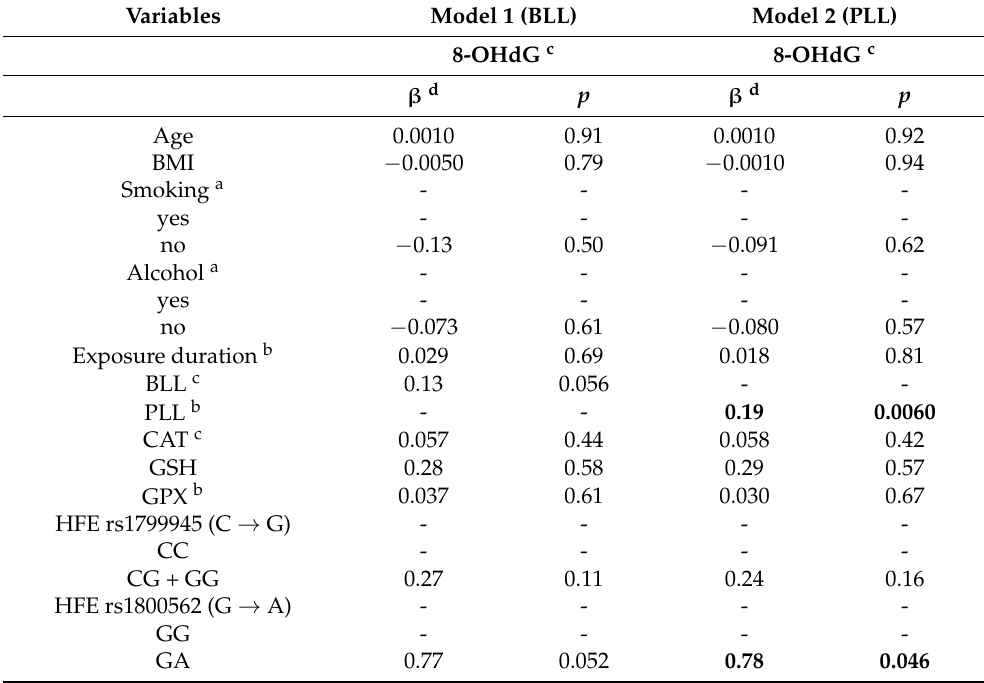
Table 3. Impact of HFE polymorphisms on urinary 8-OHdG, as a function of blood lead levels (BLL; model 1); and plasma lead levels (PLL; model 2) adjusted for age, body mass index (BMI), exposure period, smoking, alcohol, catalase (CAT), glutathione (GSH), and glutathione peroxidase (GPX).